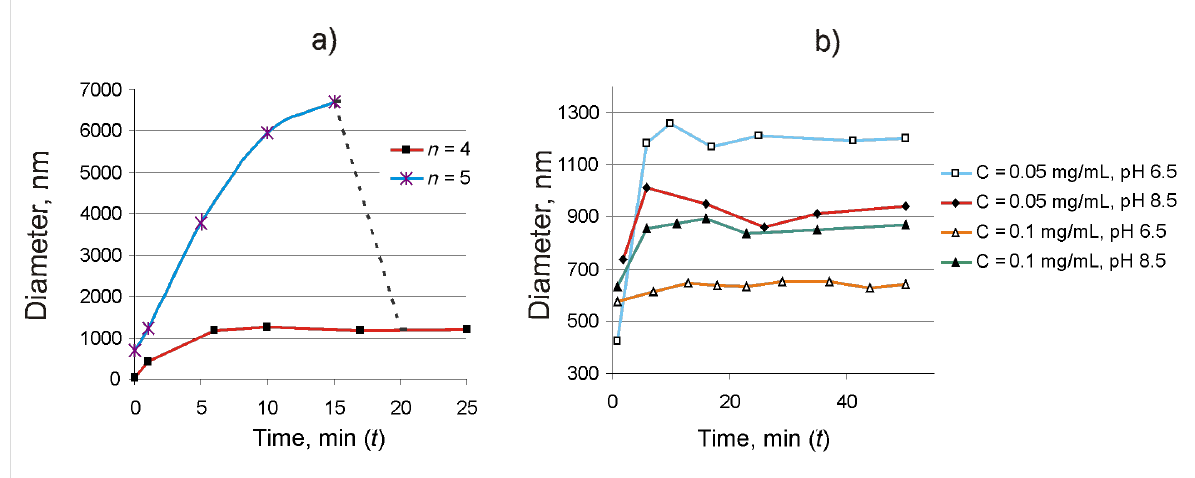
Figure 2: Dynamics of associate formation by biantennary oligoglycines Н -Gly n -NH( СН 2 ) 10 NH-Gly n - Н . a) n = 4–5, in aqueous solution at рН 6.5 and a concentration of 0.1 mg/mL at t = 0 and рН < 5 before the addition of base and at t > 0 and рН 6.5 after the addition of base. The region of sedimen- tation is marked with a dotted line. b) n = 4, in aqueous solution at рН 6.5 and